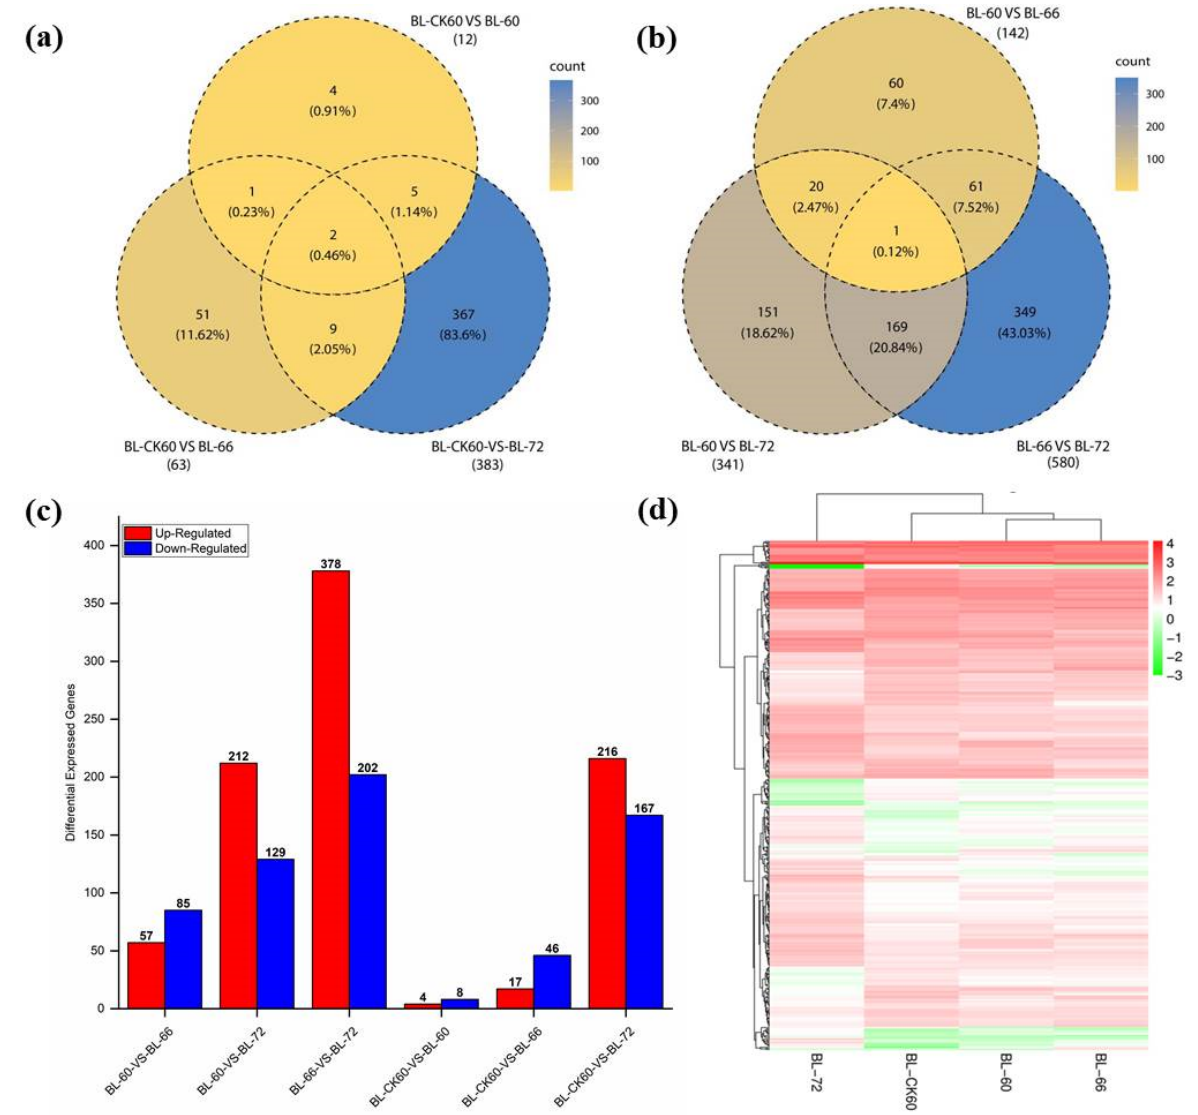
Figure 2. DEGs control vs. treatment and among treatment comparisons at 60 h, 66 h, and 72 h tested time points; ( a ) DEGs between control and treatment comparison at three tested time points (60 h, 66 h, 72 h); ( b ) DEGs among treatment comparisons at three time points (60 h, 66 h, 72 h); ( c ) Histogram representing the number of upregulated and downregulated DEGs; ( d ) Clustering heat map of all DEGs at 60 h, 66 h, and 72 h.